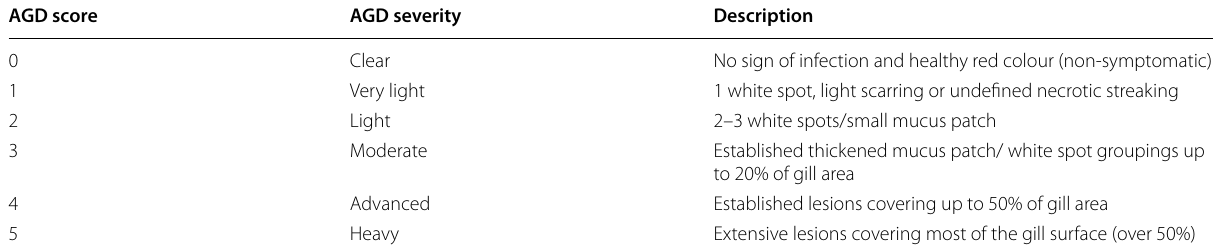
Fish were classified depending on visual inspection of the gills. White spots and mucus patches on the gills are typical indicators of an AGD infection